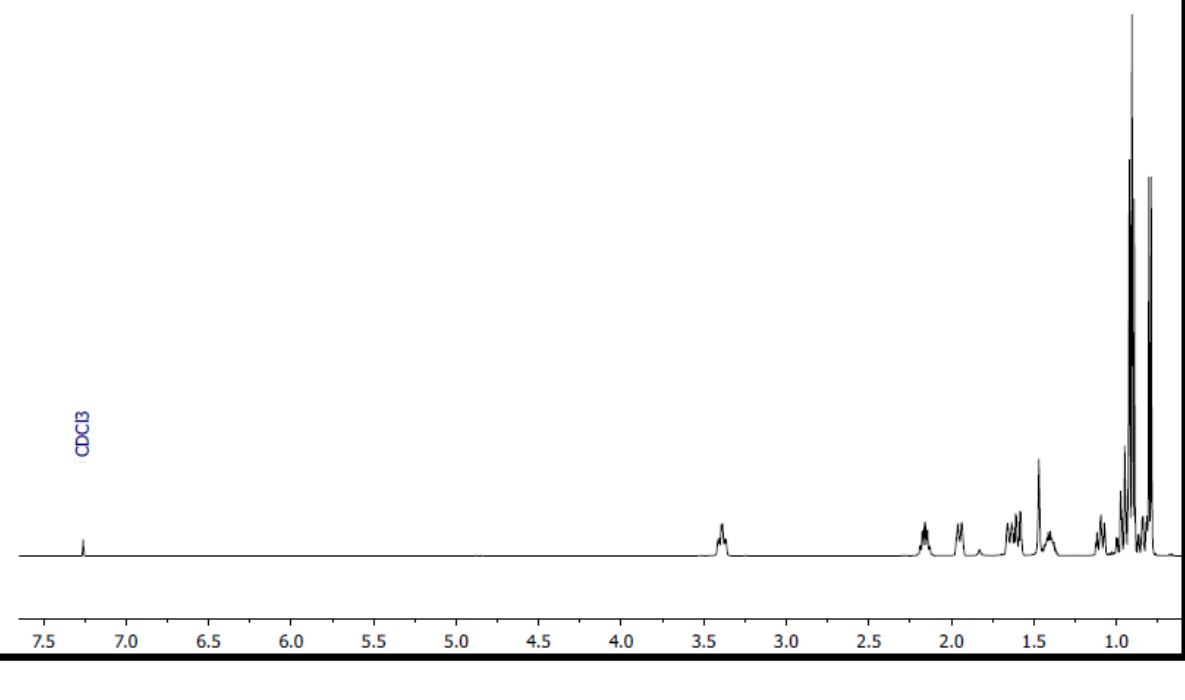
Table 3: Result of analysis of second major compound based on similarity index on GC-MS.